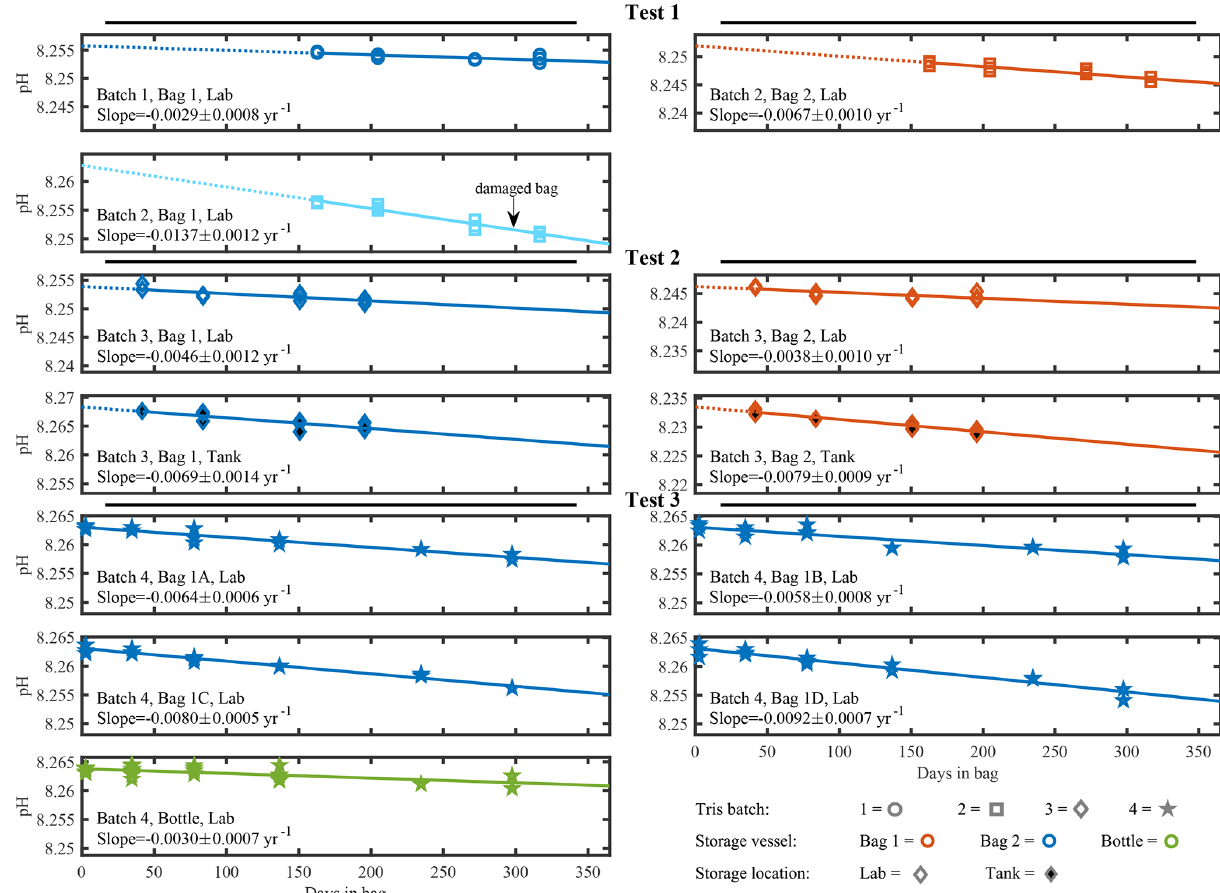
Figure 2. Individual time series of measured pH in tris buffer solutions. Tris batch is indicated by shape, storage vessel by color, and storage location by fill. This marker system is also followed in Fig. A2. The solid line is a linear regression starting at the first included pH measurement and ending 365d after the tris was bagged. The dotted line illustrates the extrapolation back to 0d stored in bag when measurements at t = 0 do not exist. The range of the y axis scale is fixed at 0.017 pH for all